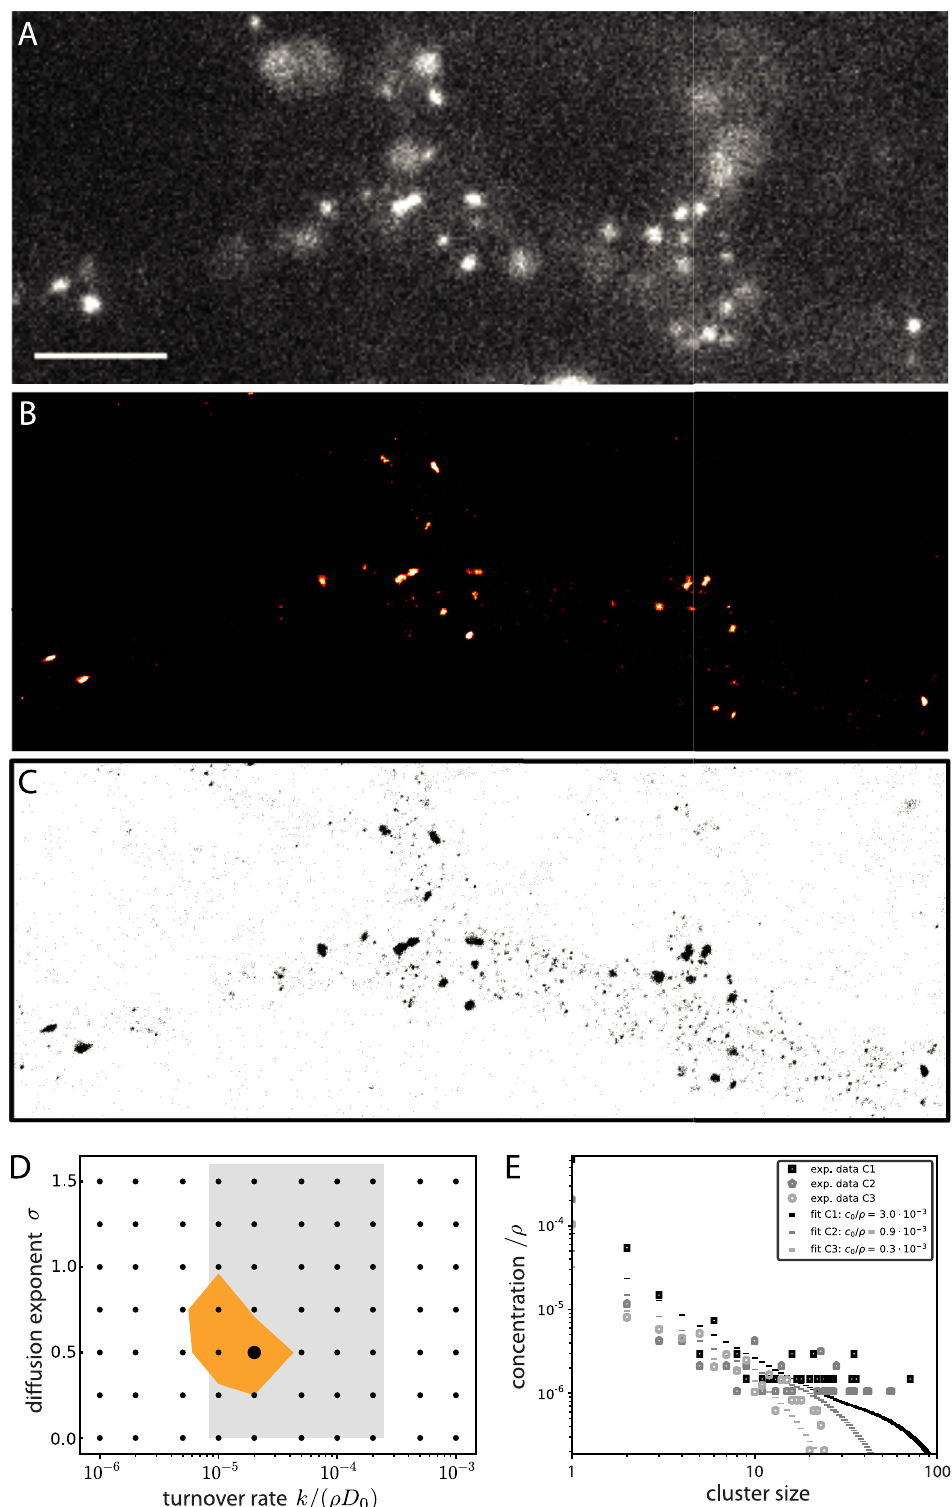
Fig 3. Gephyrin clusters and comparison with model distributions. A: Conventional fluorescence microscopy of spinalcord neuronsexpressingthe mEos2-gephyrin protein.Scale bar 5 μ m. B: Rendered super-resolution PALM image of the same segment shown in A acquiredover 20k frames at a frame rate of